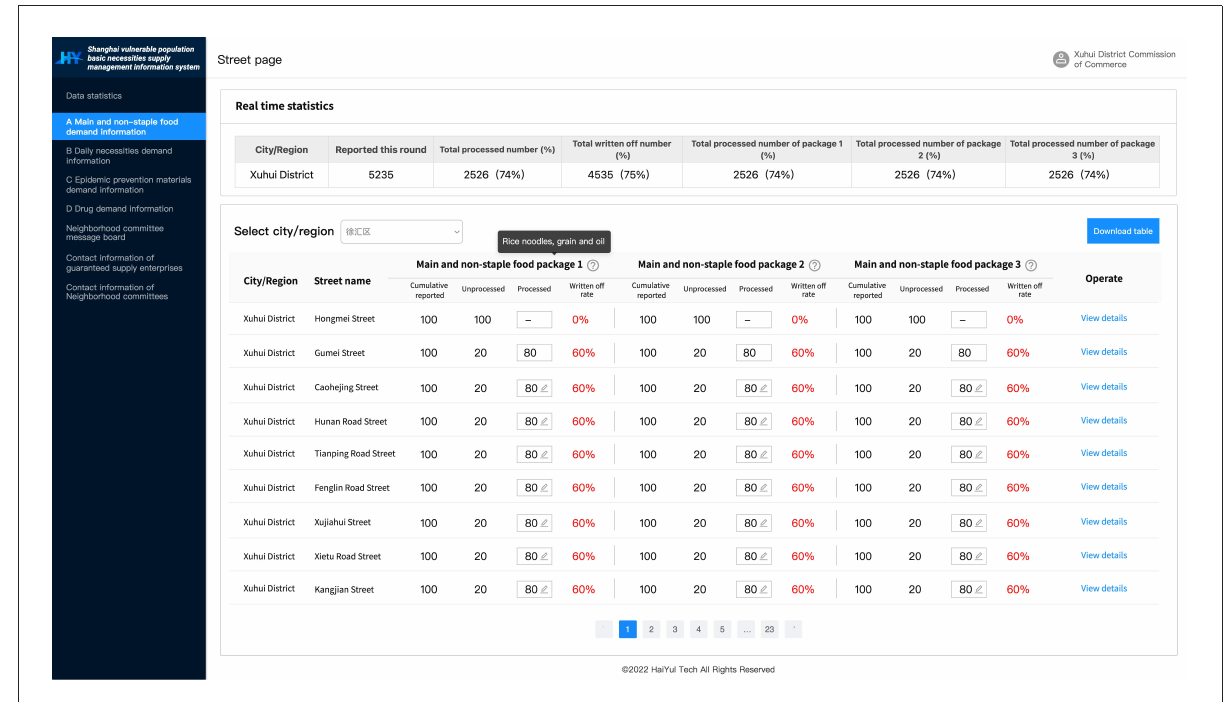
FIGURE4 Illustration of the materials allocation interface used by the commission of commerce (web